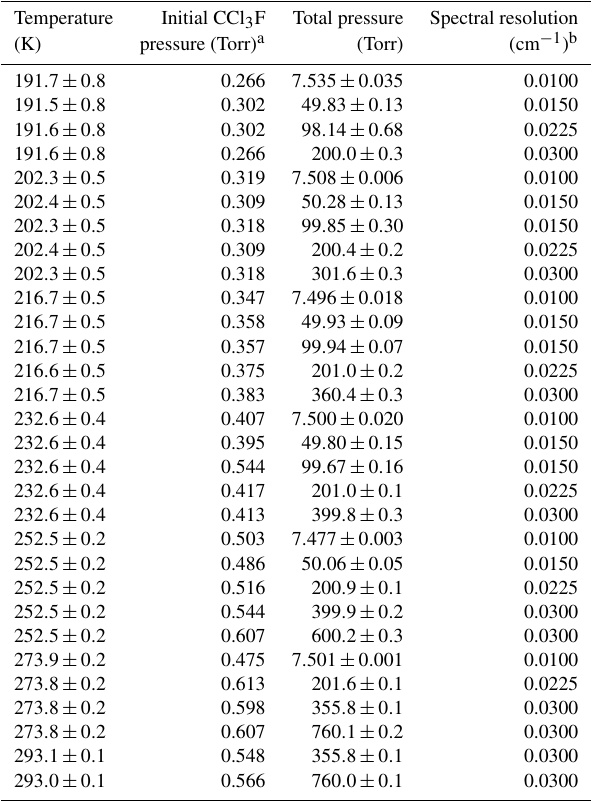
Table 3. Summary of the sample conditions for all